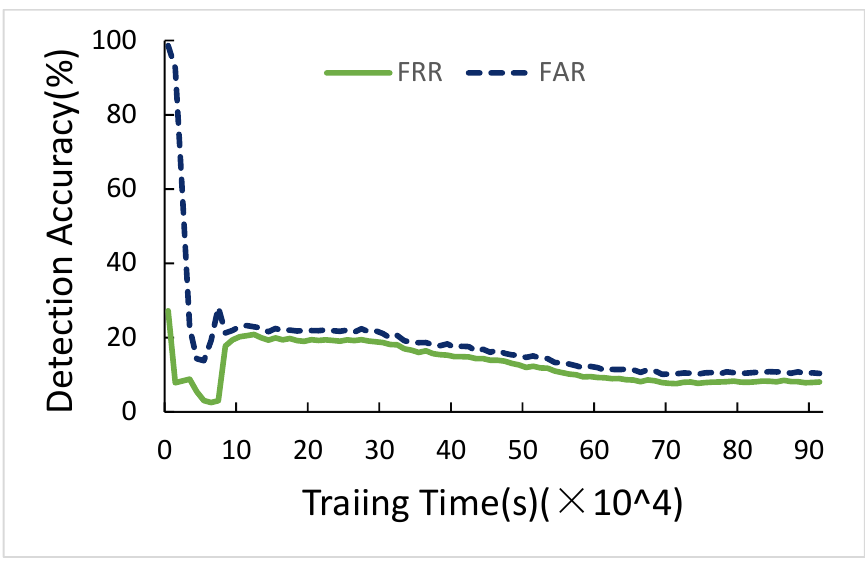
Figure 10. FRR and FAR of three convolution layers.